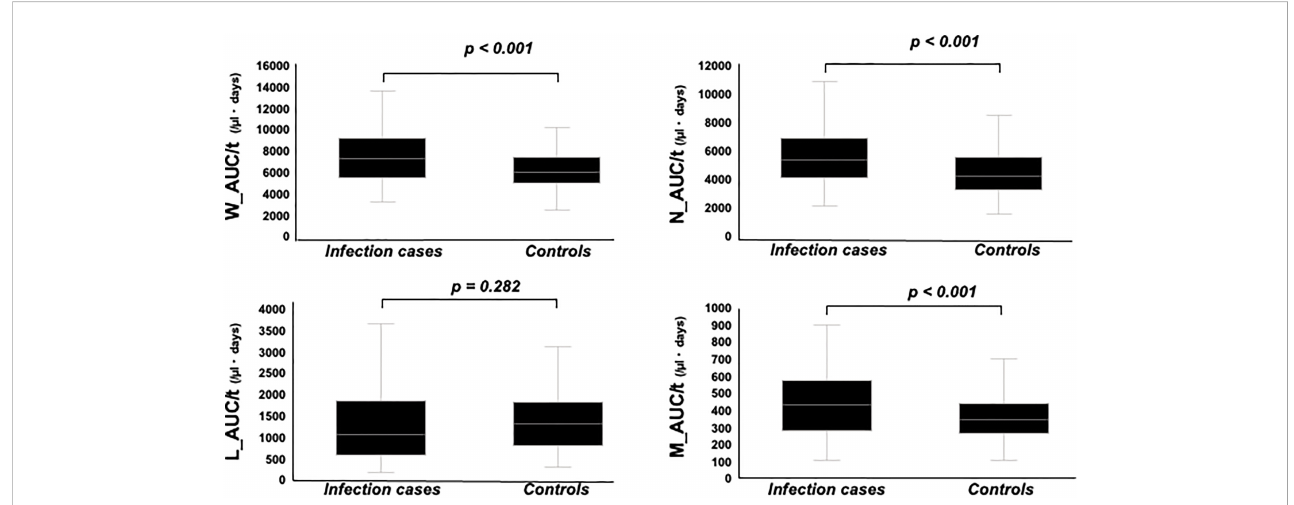
FIGURE 4 Comparison of W_AUC/t, N_AUC/t, L_AUC/t, and M_AUC/t between infection cases and controls. W_AUC/t, N_AUC/t, and M_AUC/t were signi fi cantly higher in infection cases than controls, while L_AUC/t tended to be lower in infection cases than controls, though not statistically signi fi cant.